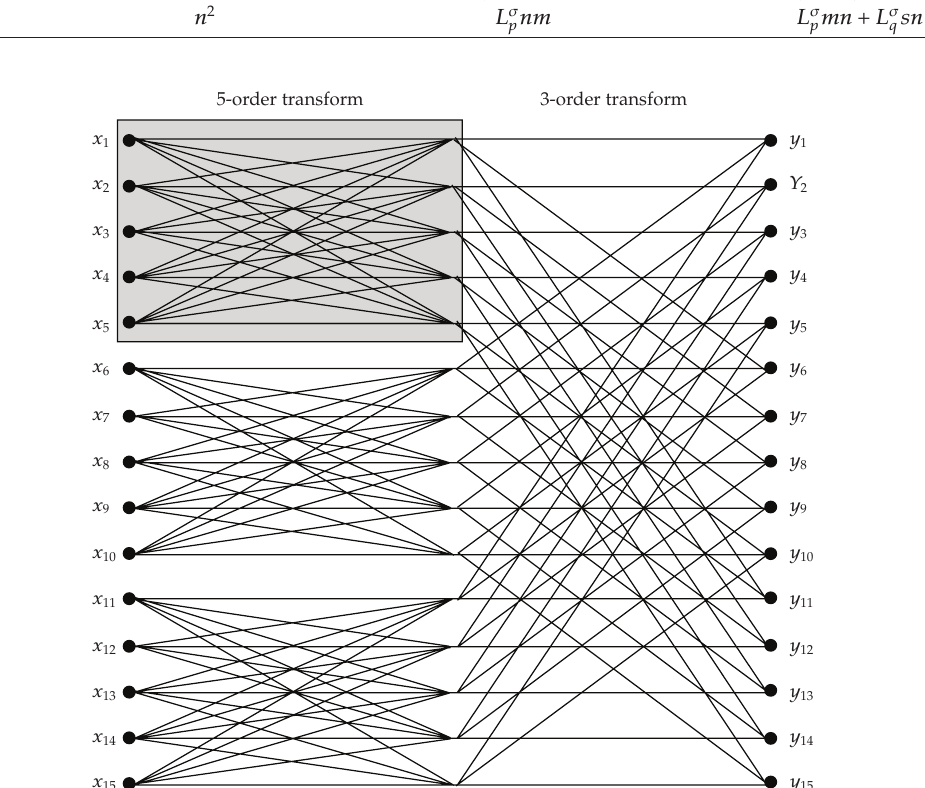
Figure 1: Signal flow graph for Pauli block transform for Q 15